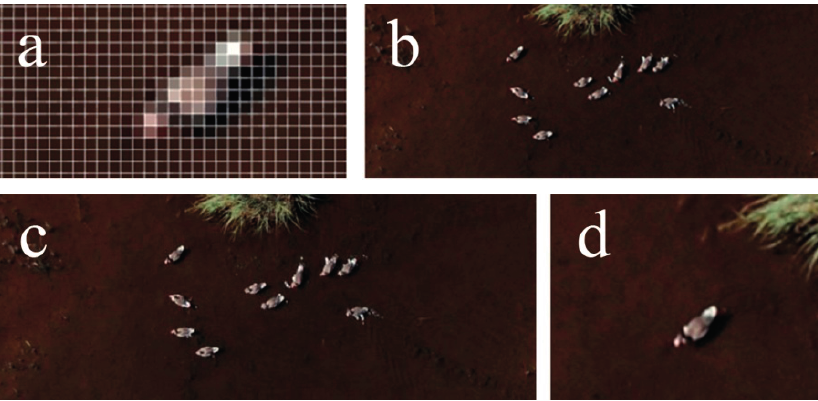
Figure 9. Ortho image map section showing ( a ) a graylag goose at the 7 cm spatial resolution (enlarged); ( b ) graylag geese at the 5 cm spatial resolution; ( c ) graylag geese at the 2.5 cm spatial resolution; ( d ) a graylag goose at the 1 cm spatial